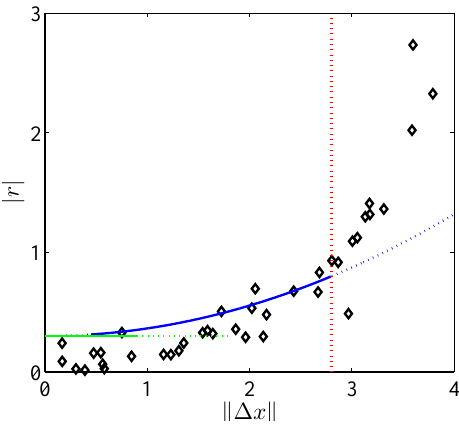
Fig. 3. Typical spatial distribution of the residuals in the one- dimensional case. The diamonds indicate the absolute values of the residuals. For small k ∆ x k , the measurement errors dominate (measurement error bound: green line). At intermediate values, the second-order behaviour is evident (measurement error plus second- order term: blue curve). For larger k ∆ x k , higher-order terms play a role and may result in residuals whose upper bound can be higher or lower. The goal of solution adaptivity is to find the homogene- ity length scale (marked by the dashed vertical line), at which the transition of second-order to higher-order behaviour occurs.